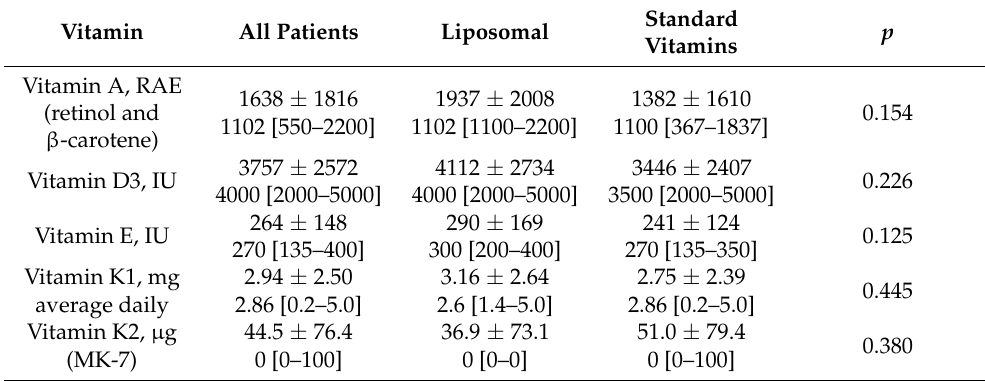
Table 3. Daily doses of vitamins prior to the study. Mean ± SD is provided.